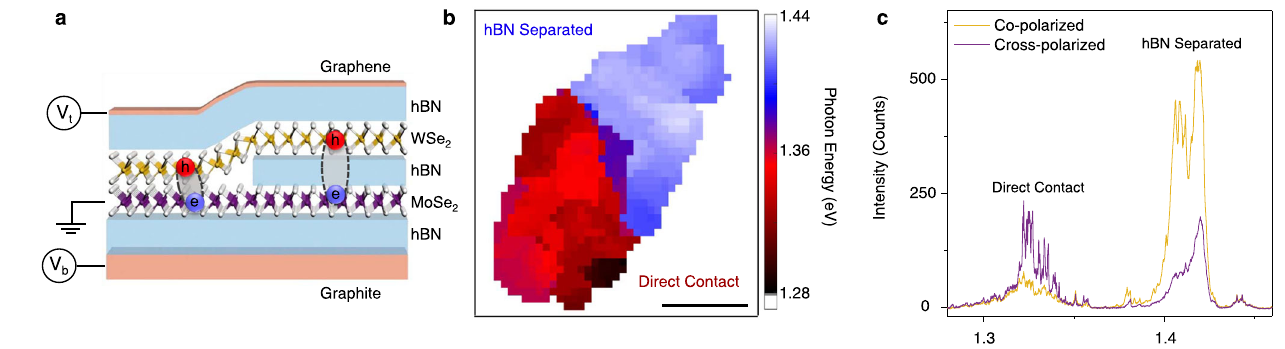
Fig. 1 | Schematic of the sample and spatially resolved IX photoluminescence. a Cartoon depiction of the device shows the WSe 2 – MoSe 2 heterostructure encap- sulatedwithhBN.Bilayergrapheneisusedforthetop gateandgraphiteisusedfor the bottom gate. Approximately half of the TMD heterostructure is separated by bilayer hBN to suppress the moiré potential. b Confocal PL spatial map of this device, plotting the average center IX photon energy. The hBN separated region is